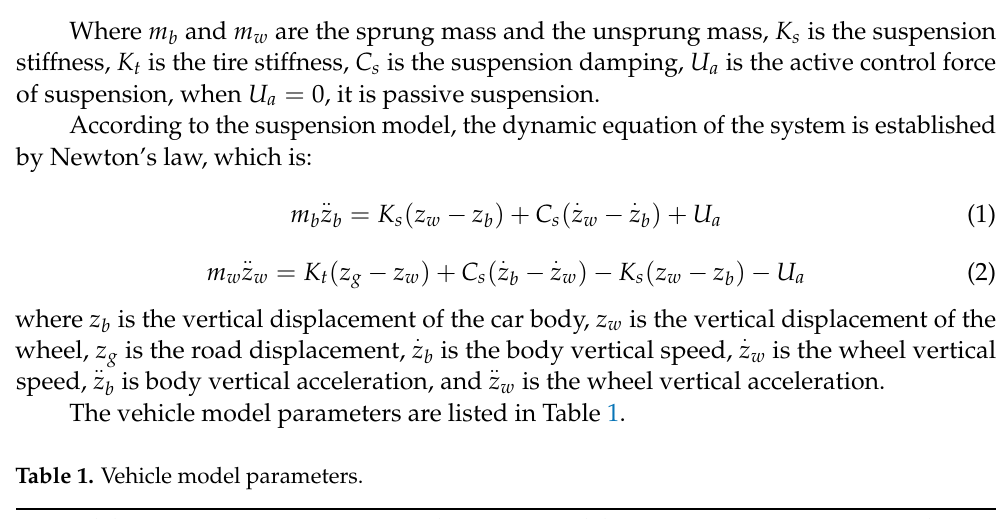
Figure 2. 2-DOF 1/4 vehicle dynamics model.